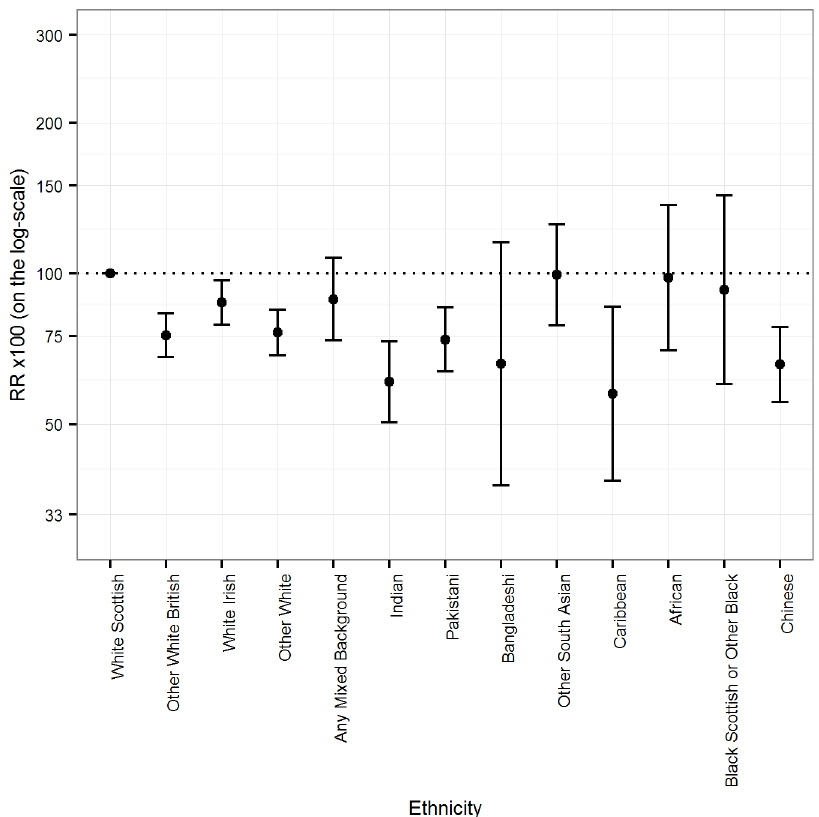
Fig 2. Age-adjusted rate ratios (RRs) (bars show 95% CIs) for all-cause mortality by ethnicity in females.